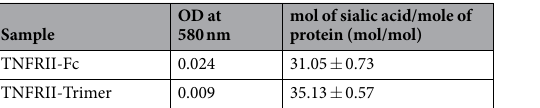
Table 1. Sialic acid (SA) estimation was performed by resorcinol methods. Note: each sample was measured in triplicate, and took the mean to eradicate any discrepancies. Data was shown in Mean ±